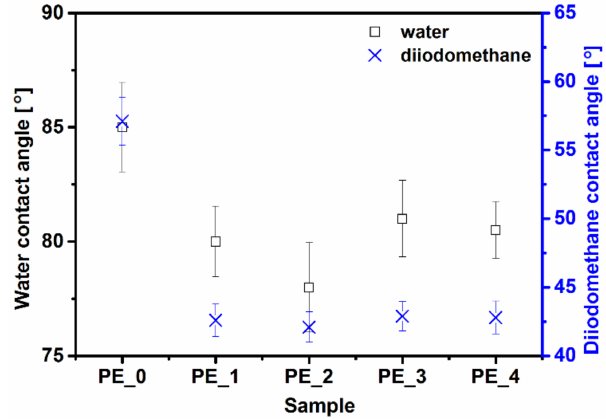
Figure 4. Contact angle values for water (black) and diiodomethane (blue) of PE surface before and after plasma